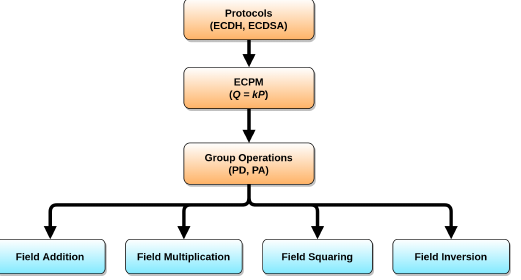
Figure 1. Elliptic Curve Cryptography (ECC) implementation